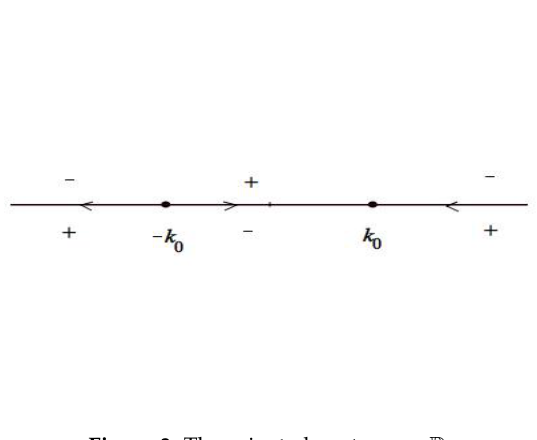
Figure 3. The oriented contour on R